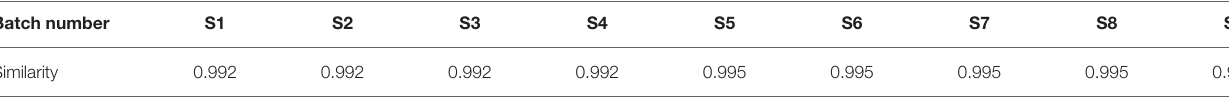
TABLE 1 | Similarity results between different batches of MPTA and shared patterns ( n = 9). Batch number